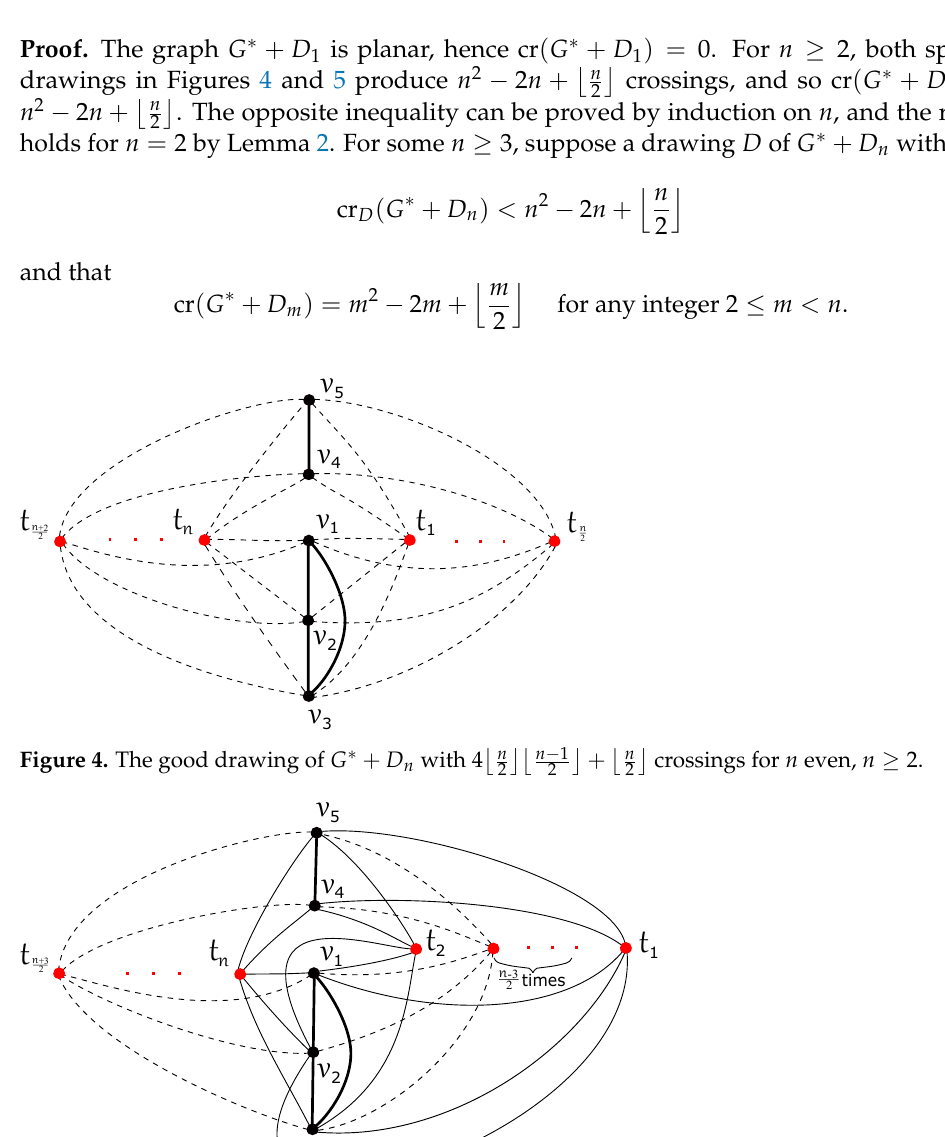
Figure 5. The good drawing of G ∗ + D n with 4 three subgraphs T 1 , T 2 , and T n are